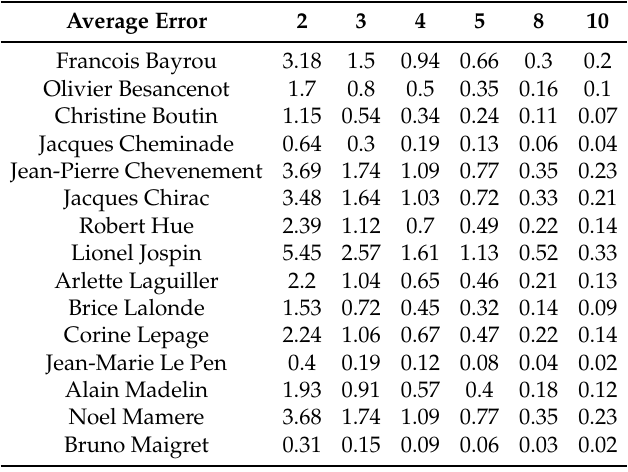
Table 18. Average flooring error for French election.